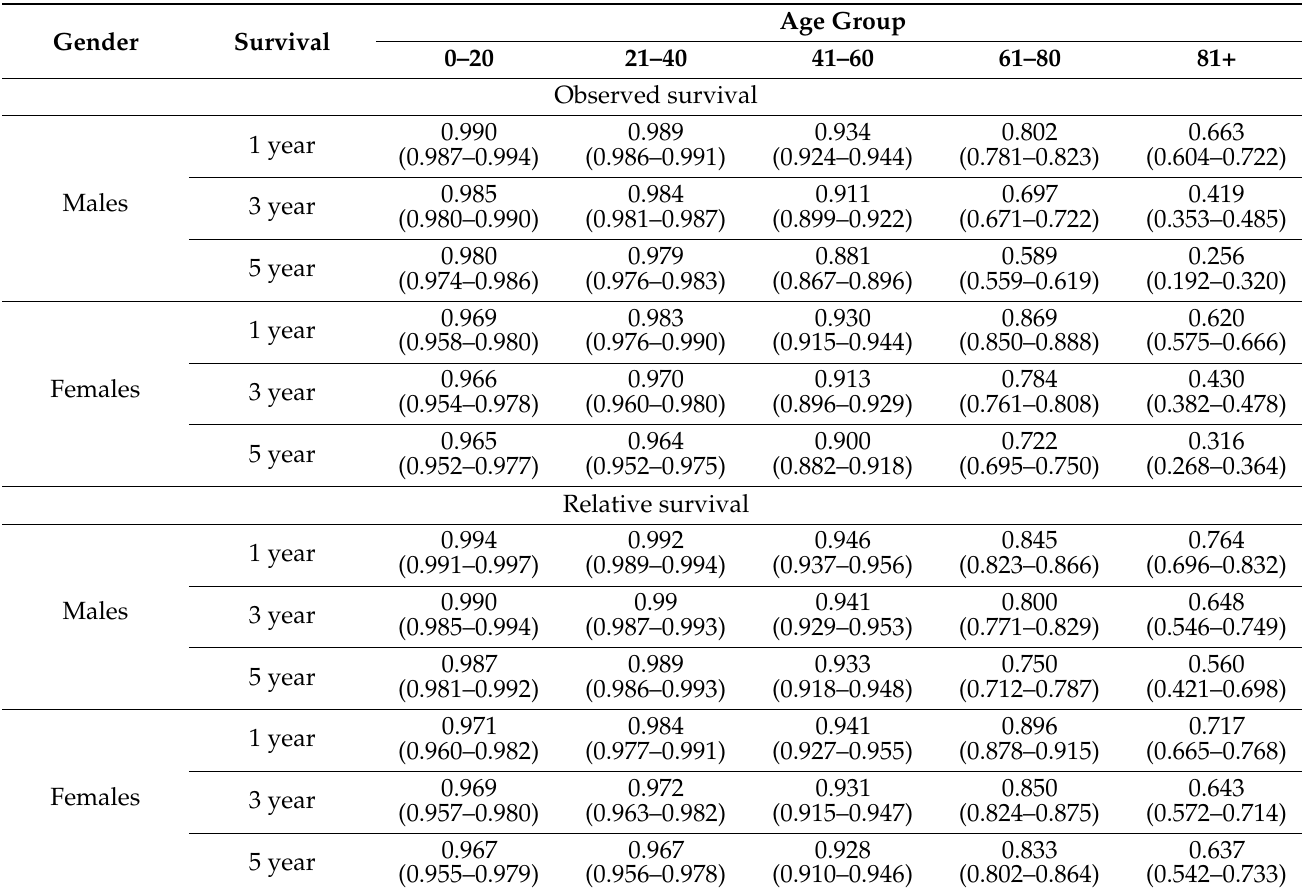
Table 3. Observed and relative survival by sex and